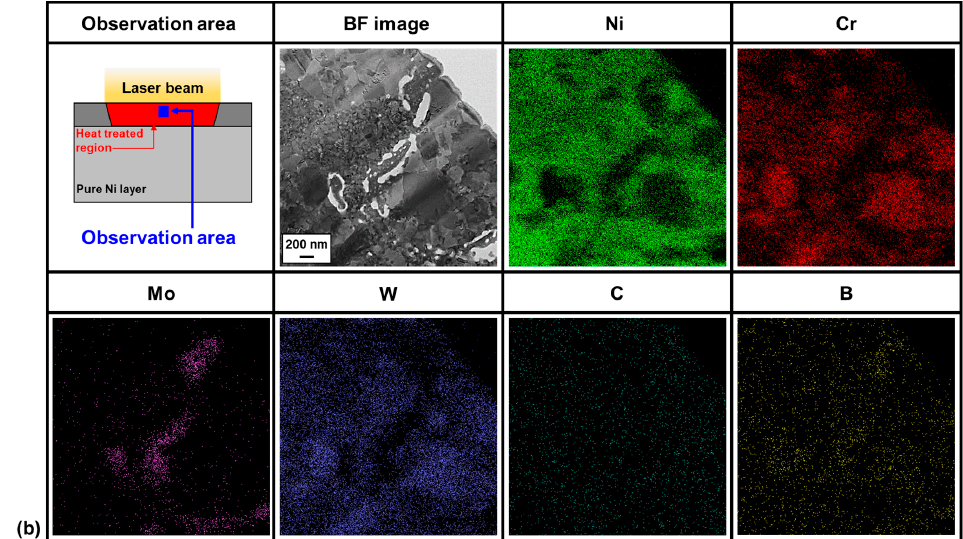
Figure 8. ( a ), ( b ) BF image and EDS analysis of thermal-sprayed 1276F coating after laser-assisted fusing treatment at 1473 K.